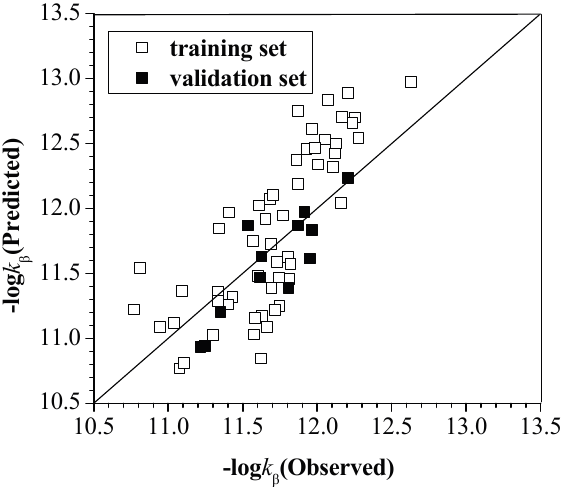
Figure 2. The observed values and predicted values of − log k α for the training and validation set.